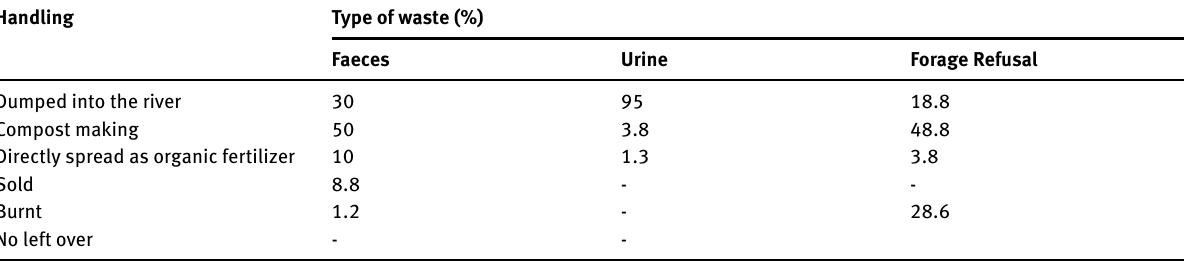
Table 6: The Farm Waste Handling Handling